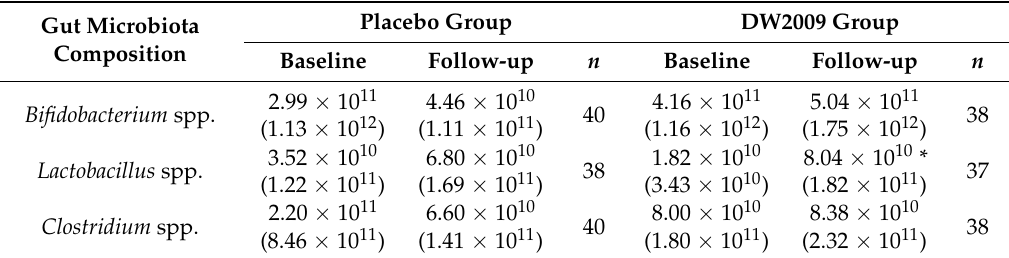
Table 3. Effect of DW2009 on the bifidobacteria, lactobacilli, and clostridia.